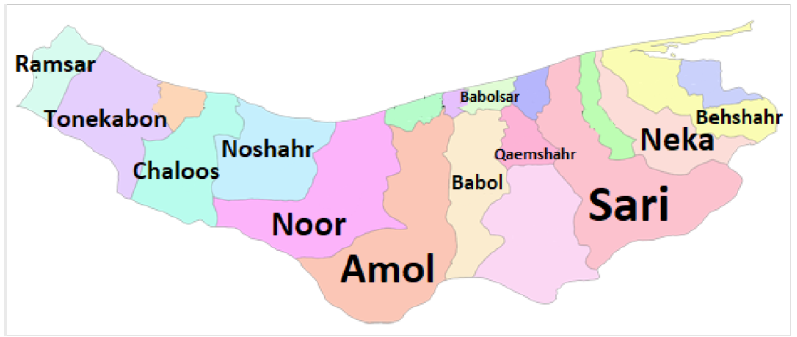
Figure 12. Map of cities. Table 4. Related datasets to the cities.